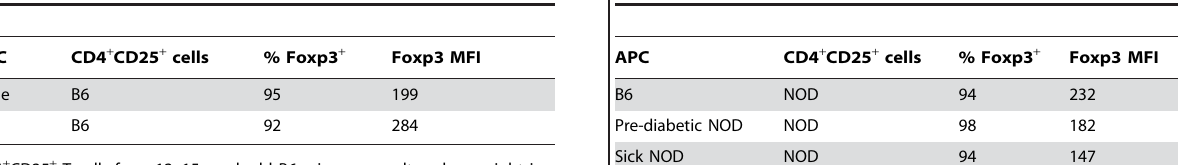
Table 3. APC from pre-diabetic and Sick NOD mice are less efficient at maintaining Foxp3 expression in vitro